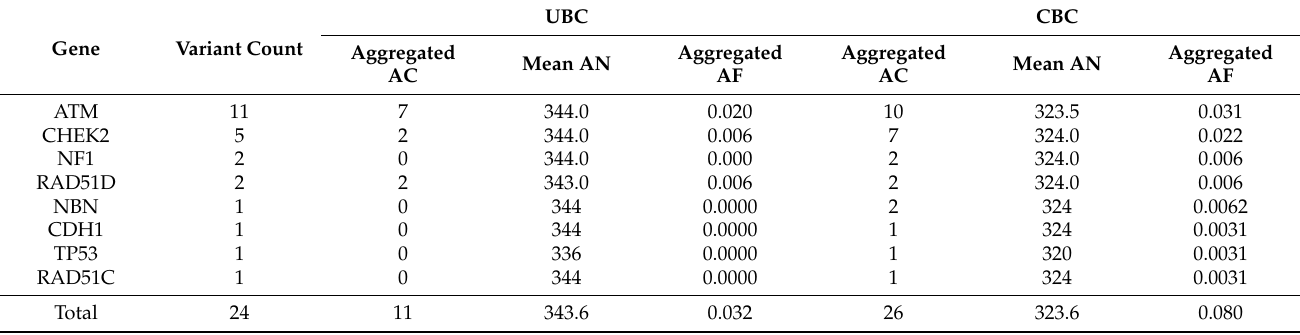
Table notes: Aggregated ALT allele count (aggregated AC) was calculated as sum of ALT allele counts over all variants detected in a gene. Mean allele number (mean AN) was calculated as an arithmetic mean of total allele counts for each variant detected in a gene. For instance, if a gene had two variants, and one of them had AN 345 while the other had AN 346, then the mean AN would be 345.5. Aggregated ALT allele frequency (aggregated AF) was calculated as the total count of ALT alleles (aggregated AC) over the mean allele number (mean AN) across the aggregated variants. No pathogenic variants were identified in the other genes studied in Group